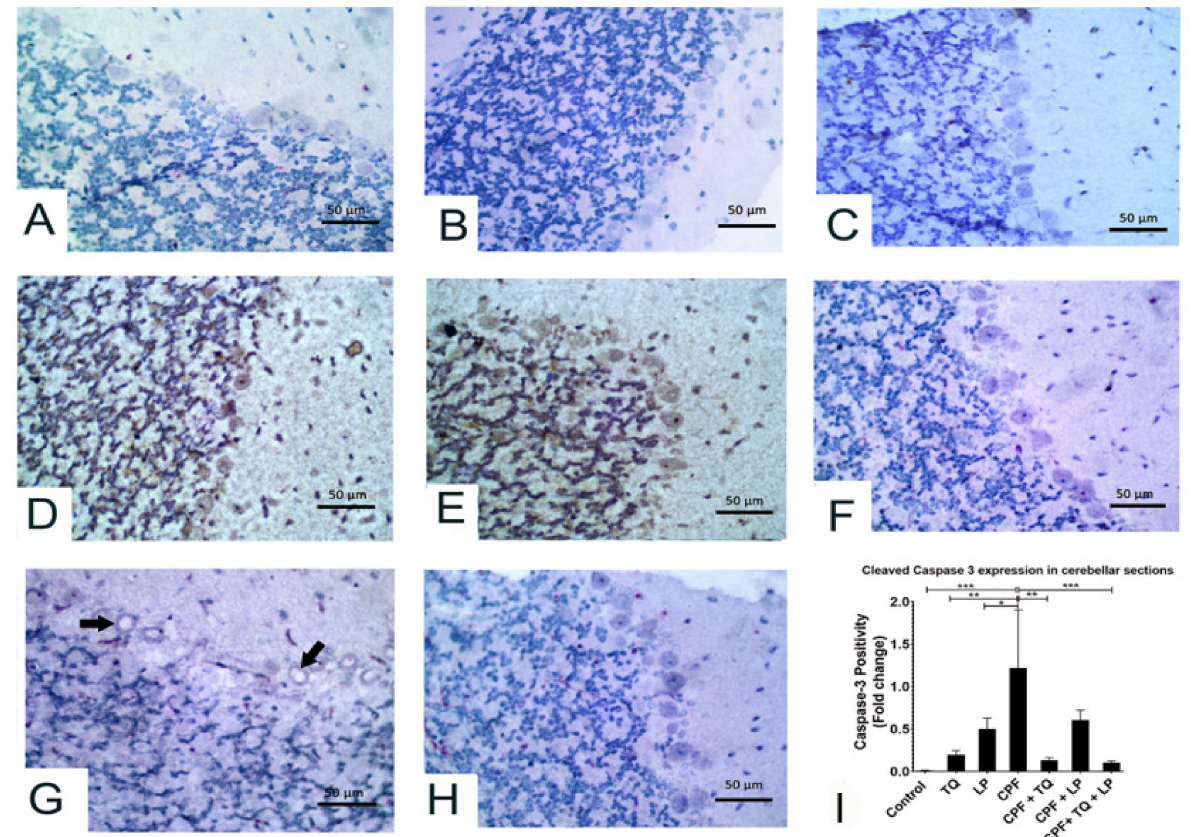
Figure 6. Immunohistochemical staining of cleaved caspase 3 in the cerebellum. All the neurons in molecular, Purkinje and granular cell layers displayed no caspase 3 staining in control ( A ), TQ- ( B ) and LP- ( C ) treated rats. ( D , E ) Most Purkinje cells and many neurons in granular and molecular cell layers showed strong caspase 3 staining in CPF intoxicated rats. ( F ) Most neurons in all the cerebellar layers had no caspase 3 staining in TQ + CPF treated rats. ( G ) Certain Purkinje cells were vacuolated and moderately stained with cleaved caspase 3 in LP + CPF treated rats. ( H ) All the neurons in the cerebellar sections were devoid of caspase 3 staining in TQ + LP + CPF treated rats. ( I ) Bar graph represents the relative cleaved caspase 3 positivity in cerebellar sections of different groups compared to CPF intoxicated group. Substantial differences are exhibited as: * p ≤ 0.05, ** p ≤ 0.01, and *** p ≤